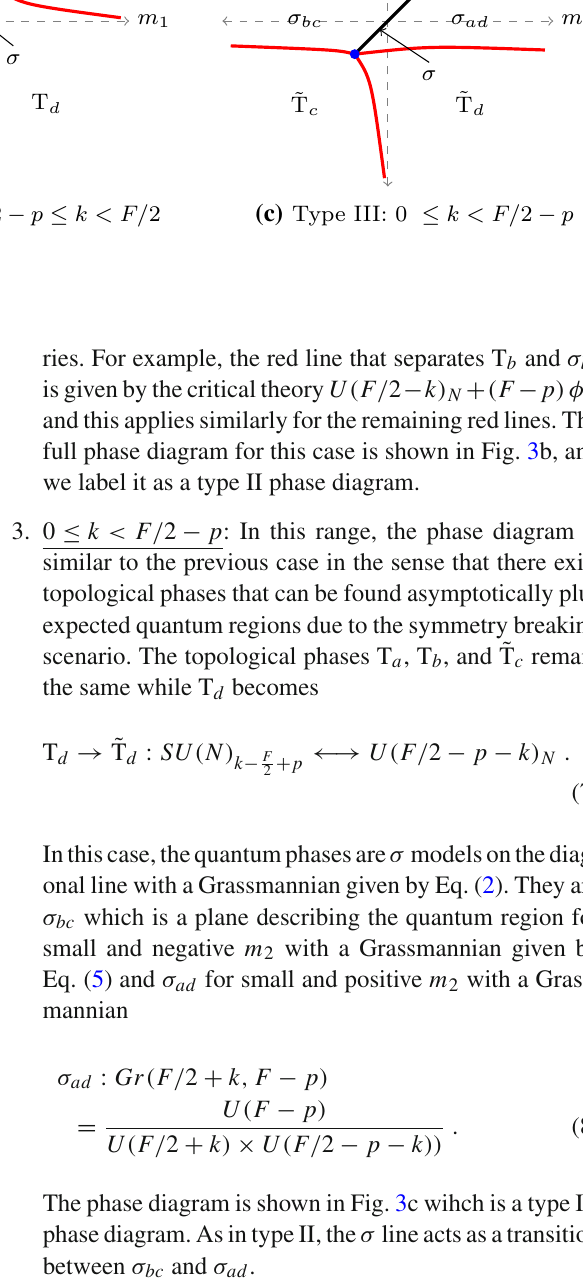
Fig. 3 Phases of SU ( N ) k + p ψ 1 + ( F − p )ψ 2